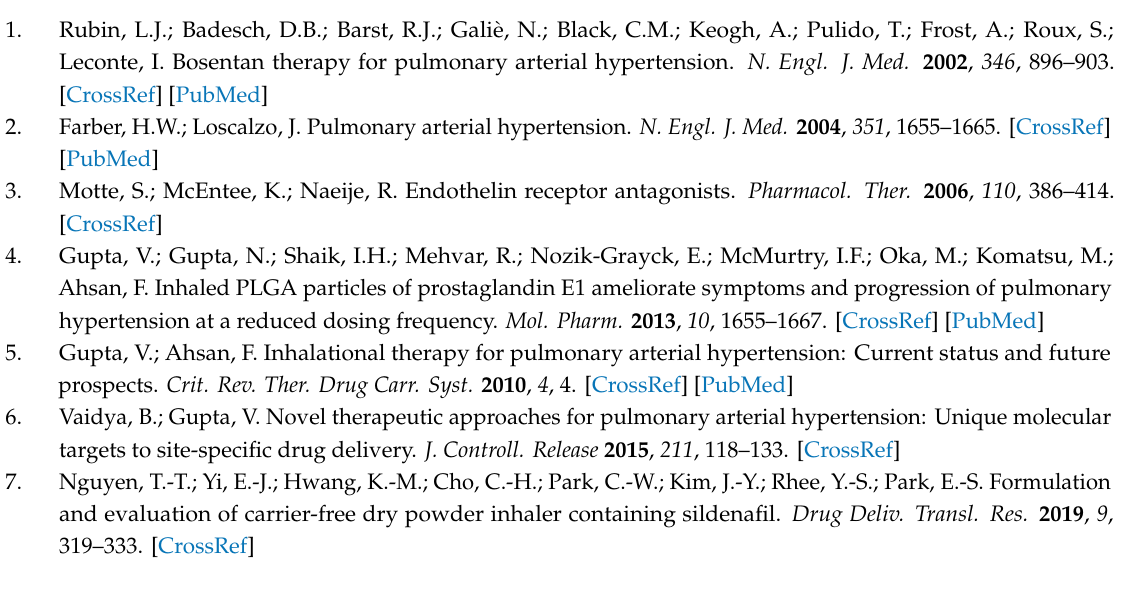
Figure S1: XRD di ff ractograms of spray-dried bosentan microparticles and raw bosentan. Video S1: Actual movement of SD100, Video S2: Actual movement of SD80, Video S3: Actual movement of SD60. Author Contributions: Conceptualization, Y.-B.K. and C.-S.H.; validation, Y.-B.K. and J.-H.K.; formal analysis, C.-S.H.; Data curation, J.-H.K.; investigation, C.-W.P.; writing—original draft preparation, Y.-B.K. and C.-S.H.; writing—review and editing, J.-H.K., D.-W.K., and C.-W.P.; supervision, C.-W.P. All authors have read and